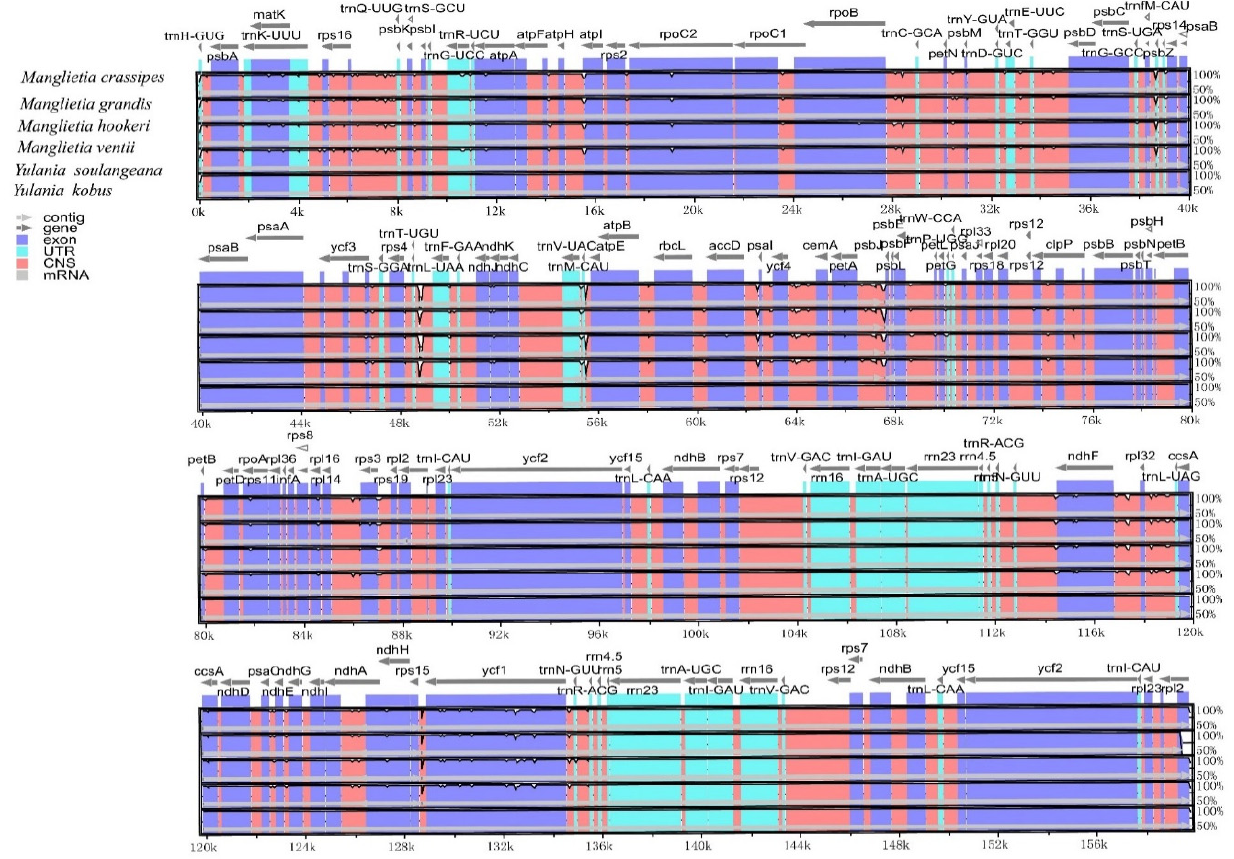
Figure 2. Alignment of whole chloroplast genome sequences from the six Magnoliaceae species.